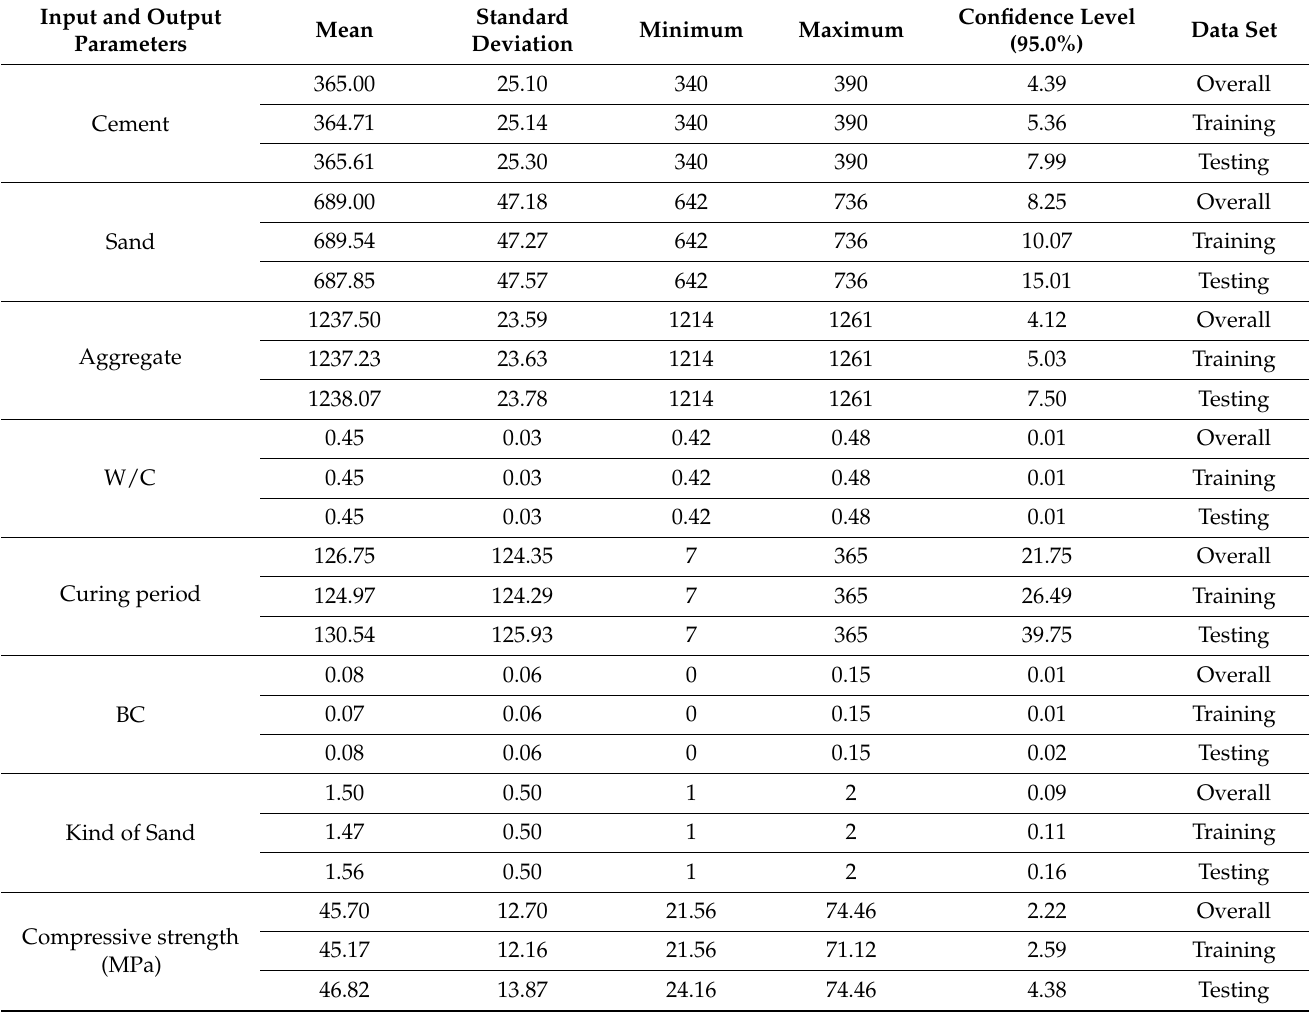
Table 5. Features of data set used the model development and